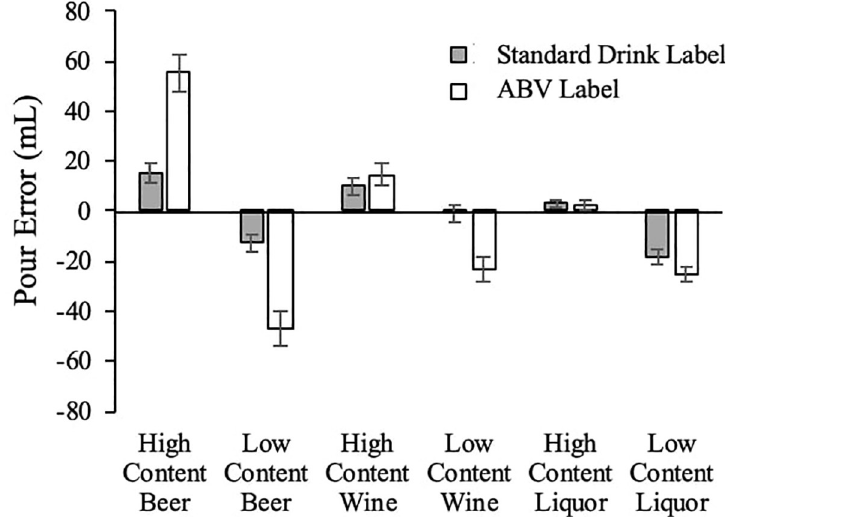
Fig 3. Mean standardized pour error by condition.